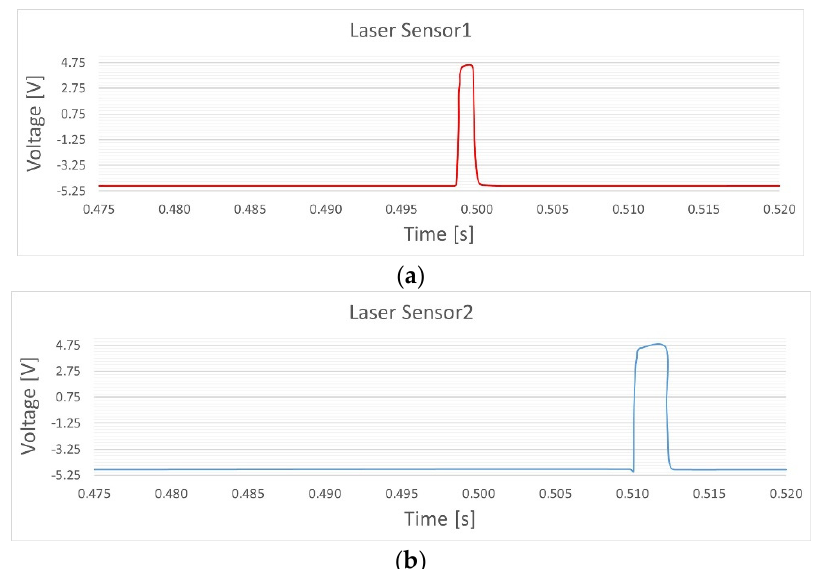
Figure 2. Sample signal data from laser sensors. ( a ) Upper laser sensor and ( b ) lower laser sensor. Table 1. Velocity test